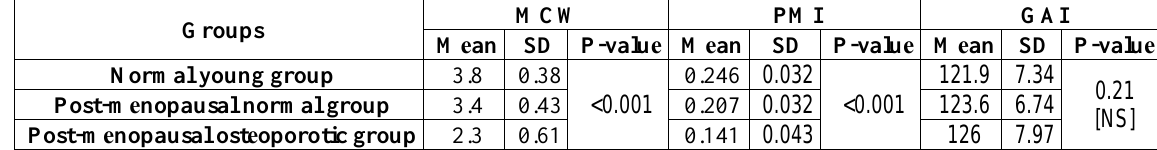
Tabl е 1: M е an valu е s of Mandibular cotical width, Panoramic mandibular ind е x and Gonial angl е ind е x according to D Е XA r е sults.